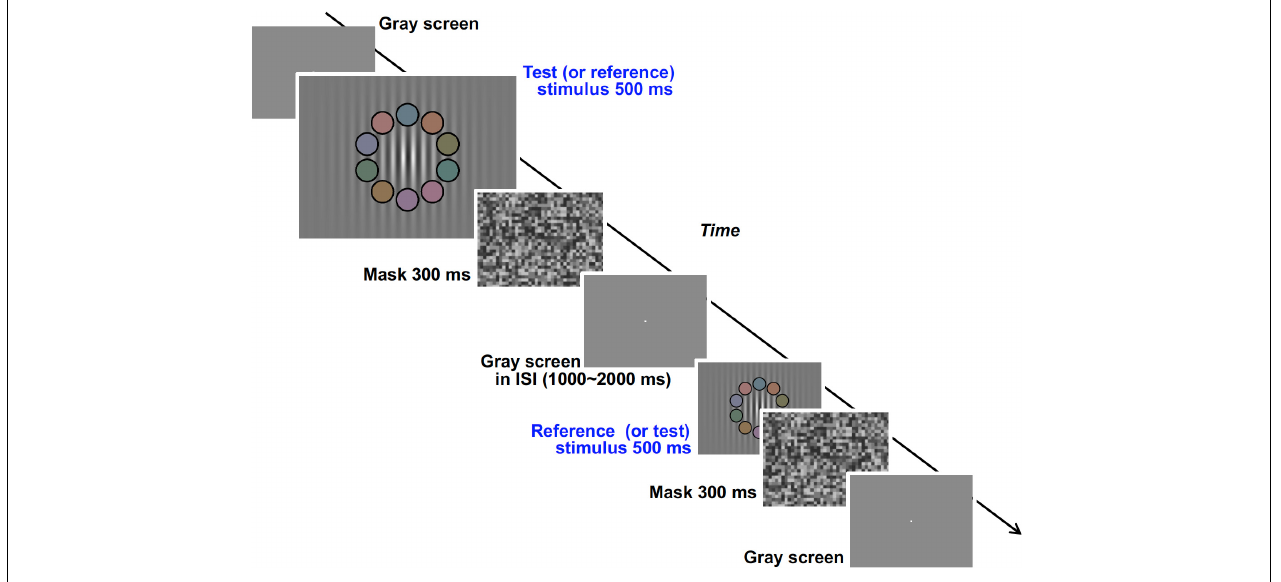
FIGURE 9 | Visual stimuli and time course of the experimental procedure in the psychophysical